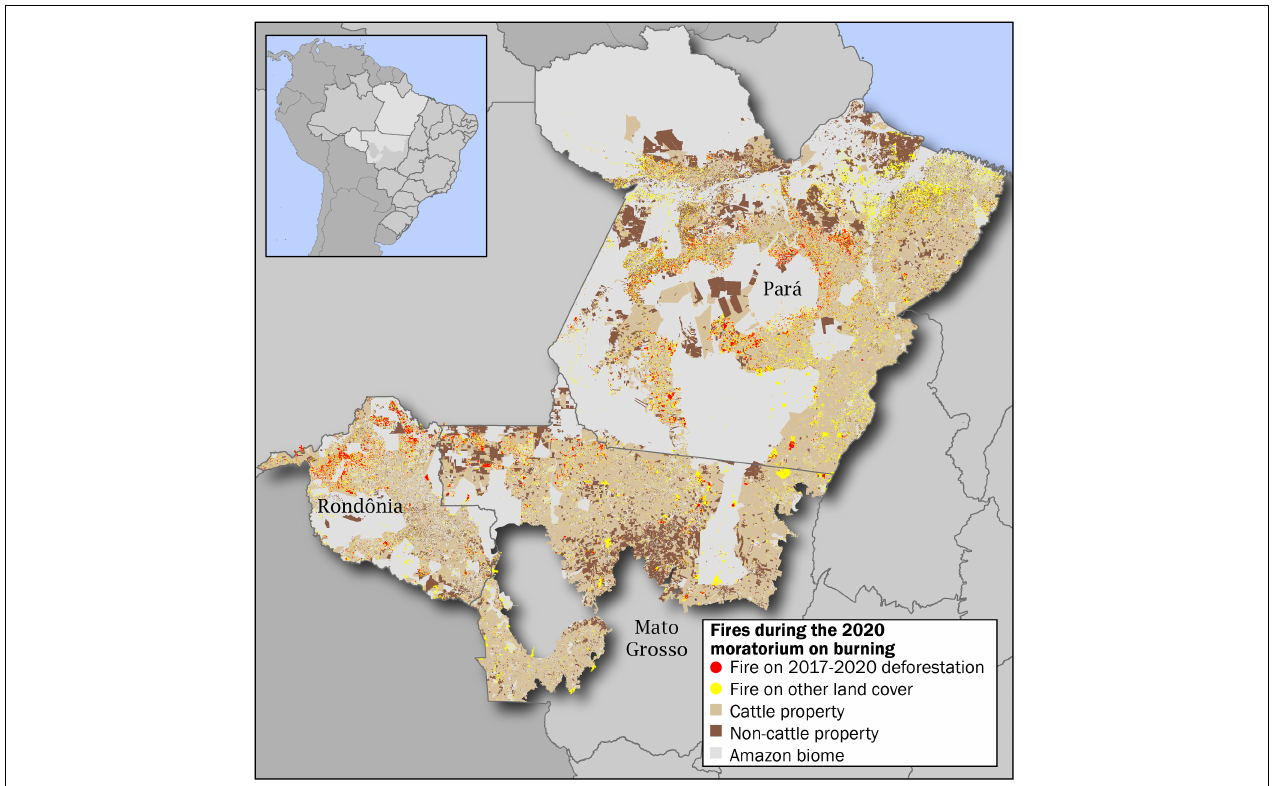
FIGURE 1 | Properties and burned area during the moratorium and type of land cover burned.